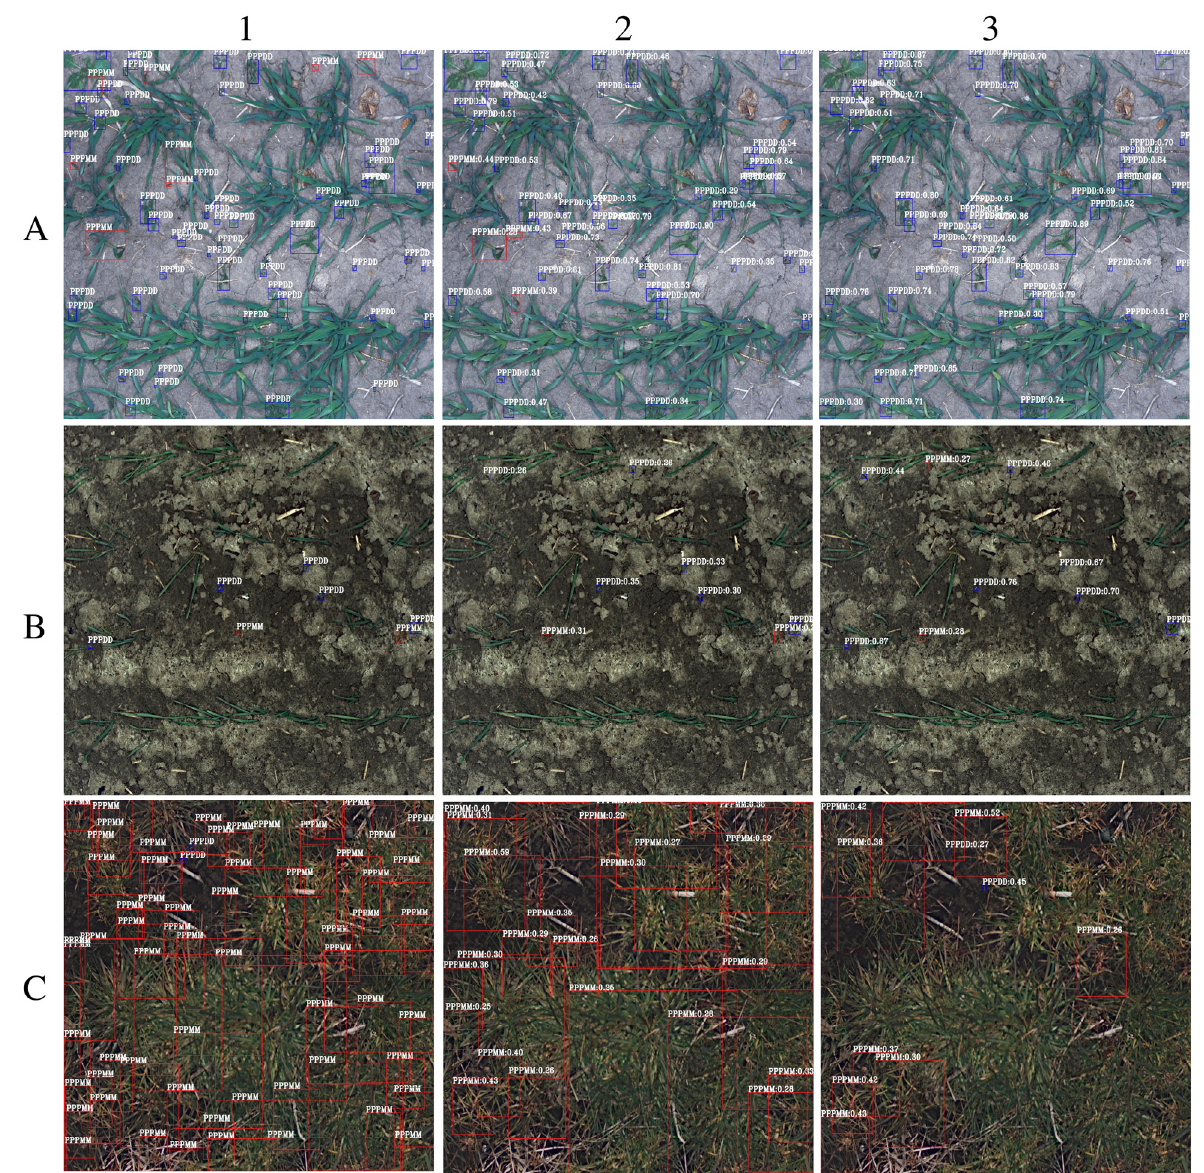
Figure 15. The monocot/dicot prediction by EfficientDet and YOLOv5 on the in-situ images: ( A1 ) The label in the light soil image; ( A2 ) The EfficientDet prediction; ( A3 ) The YOLOv5 prediction; ( B1 ) The label in the dark soil image; ( B2 ) The EfficientDet prediction; ( B3 ) The YOLOv5 prediction; ( C1 ) The label in the dense image; ( C2 ) The EfficientDet prediction; ( C3 ) The YOLOv5 prediction. In this Figure, red and blue bounding boxes represent monocot and dicot classes respectively.